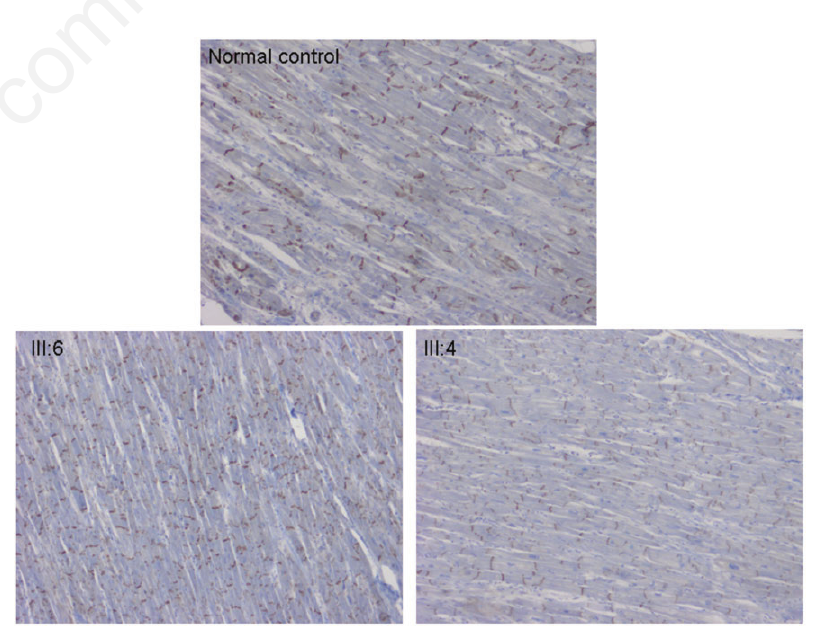
Figure 7. Immunohistochemical staining for the desmosomal protein plakoglobin in heart muscle biopsies (of patients III:4 and III:6 of the family affected with the Phe237Ser LMNA mutation). Intercalated discs show normal signal levels in a normal control sample and in both patient samples.